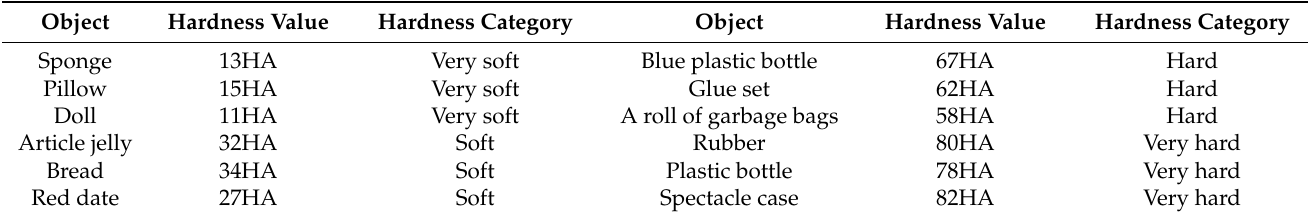
Table 1. Hardness values and categories of the 12 objects.